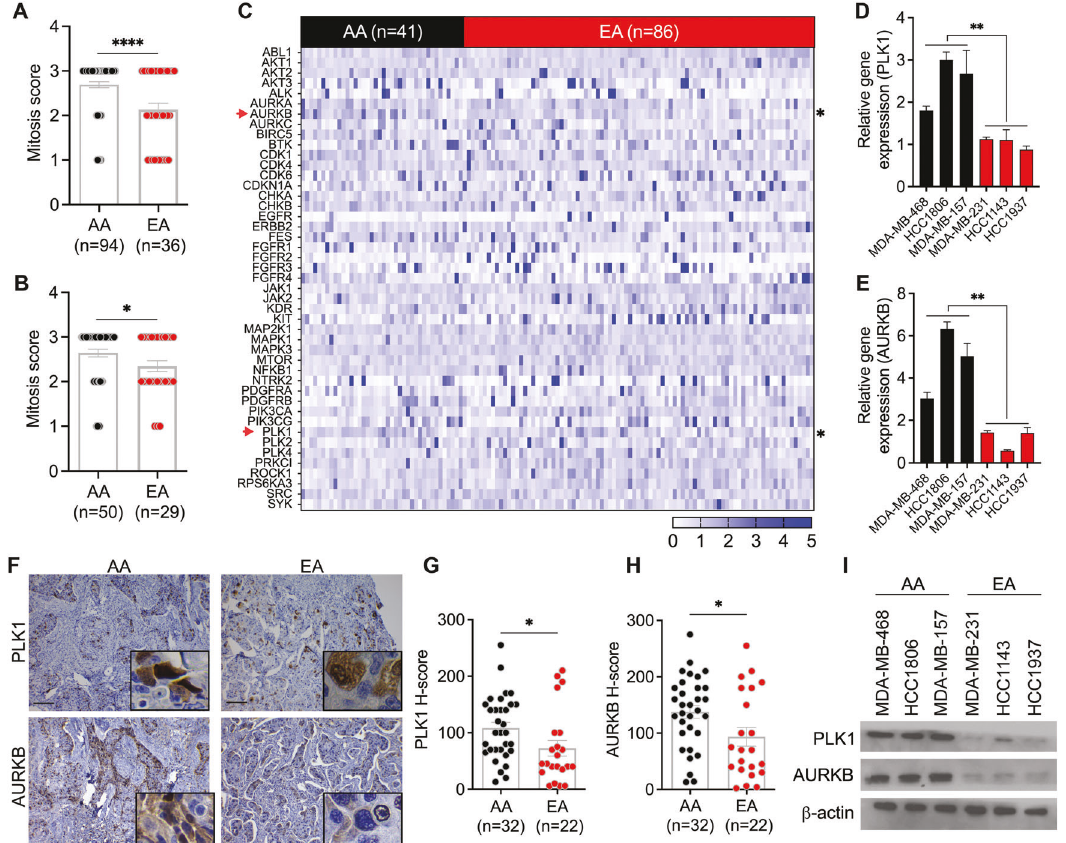
Fig. 1 PLK1 and AURKB levels in TNBC are higher in AAs than in EAs. Bar graphs showing mitosis scores in the Emory ( A ) and Dekalb ( B ) cohorts. C Heatmap showing the expression levels of various kinases in the TCGA BC dataset. D , E Bar graphs showing the expression levels of PLK1 ( D ) and AURKB ( E ) in AA ( n = 3) and EA ( n = 3) TNBC cell lines. F – H Representative IHC images of PLK1 and AURKB ( F ) and quanti fi cation bar graphs showing PLK1 ( G ) and AURKB ( H ) levels in grade- and stage-matched AA and EA patients with TNBC (Dekalb cohort). I Immunoblot showing PLK1 and AURKB protein levels in AA and EA TNBC cell lines ( n = 3 each). FPKM fragments per kilobase of transcript per million mapped reads. Bars indicate mean ± SEM. Unpaired two-tailed Student ’ s t -test with Welch ’ s correction was used to determine